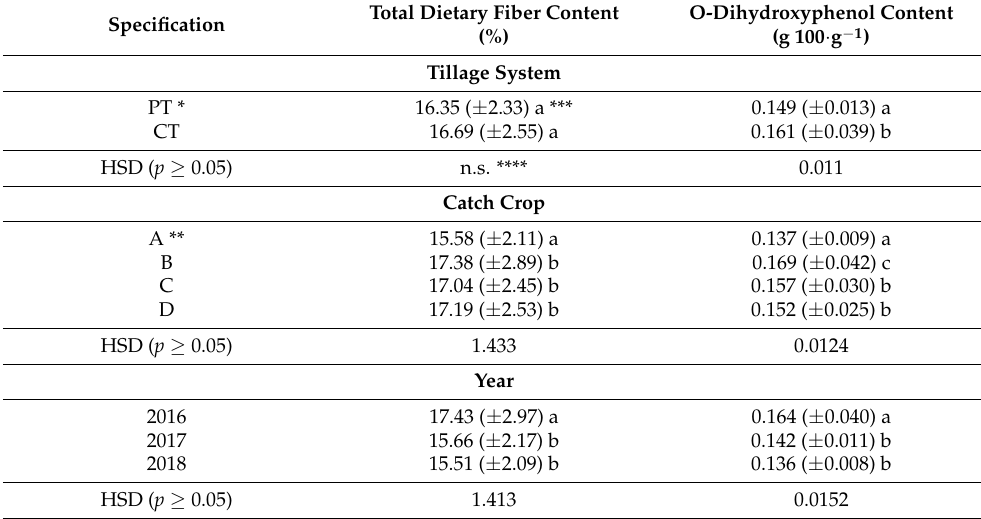
Table 8. Total dietary fiber (TDF) content and o-dihydroxyphenol content (expressed as caffeic acid equivalents) in spring wheat